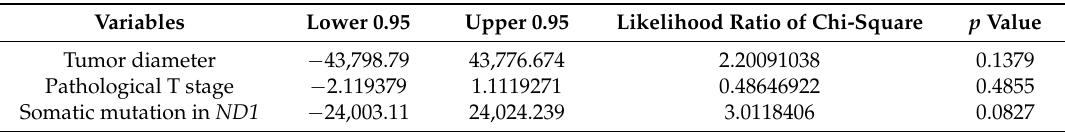
Table 6. Multivariate Cox proportional hazards regression analysis for factors associated with CSS after surgery of localized